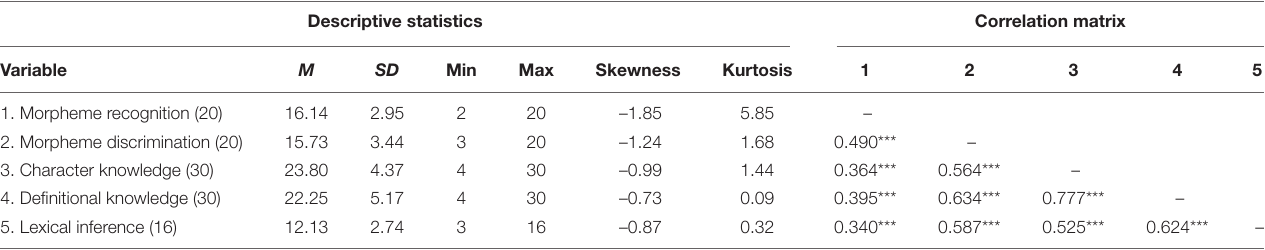
TABLE 1 | Descriptive statistics and correlations of word-knowledge facets and lexical